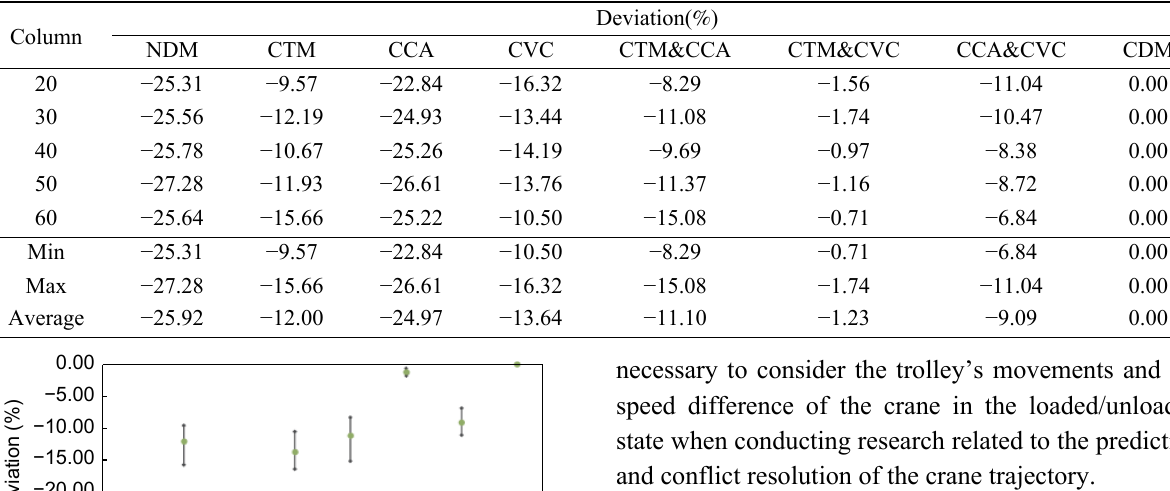
Table 6 Statistics table of deviation in different column numbers (row = 10).